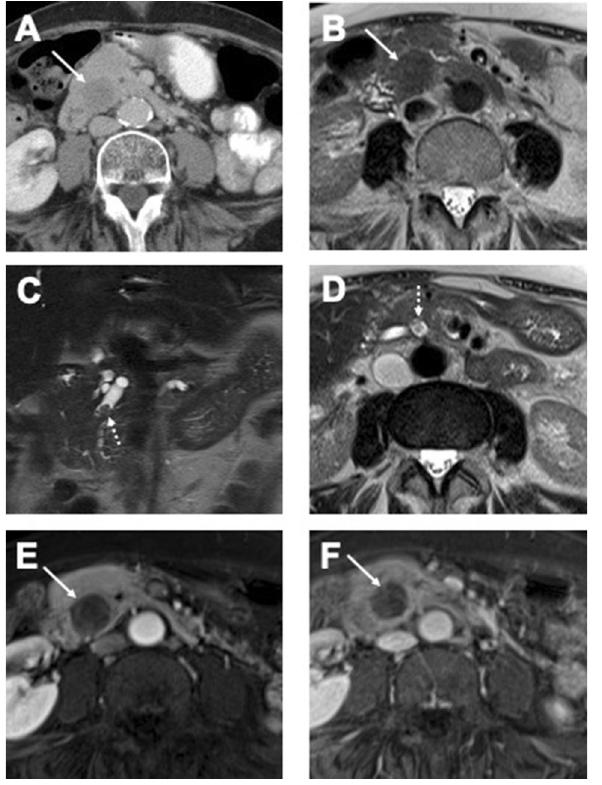
Figure 6. CT and MRI features of ITPN with intraductal solid tumor growth. ( A ) Axial CT scan in the portal venous phase shows an ITPN lesion in the pancreatic head (arrow) with well-circumscribed margins and slightly hypodense HU-values, compared to normal pancreatic parenchyma. ( B ) Axial T2 weighted image of the same patient. The lesion had T2 hypointense signal (arrow), suggesting a solid morphology. ( C,D ) Coronal T2 weighted image ( C ) and axial T2 weighted image ( D ) show dilated main pancreatic duct with intraductal solid tumor growth (dotted arrows). ( E,F ) T1 weighted images with fat suppression after contrast administration